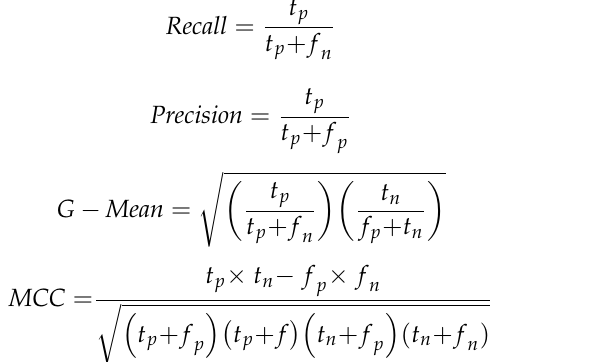
(cid:1) illustrate the best model results with and without i